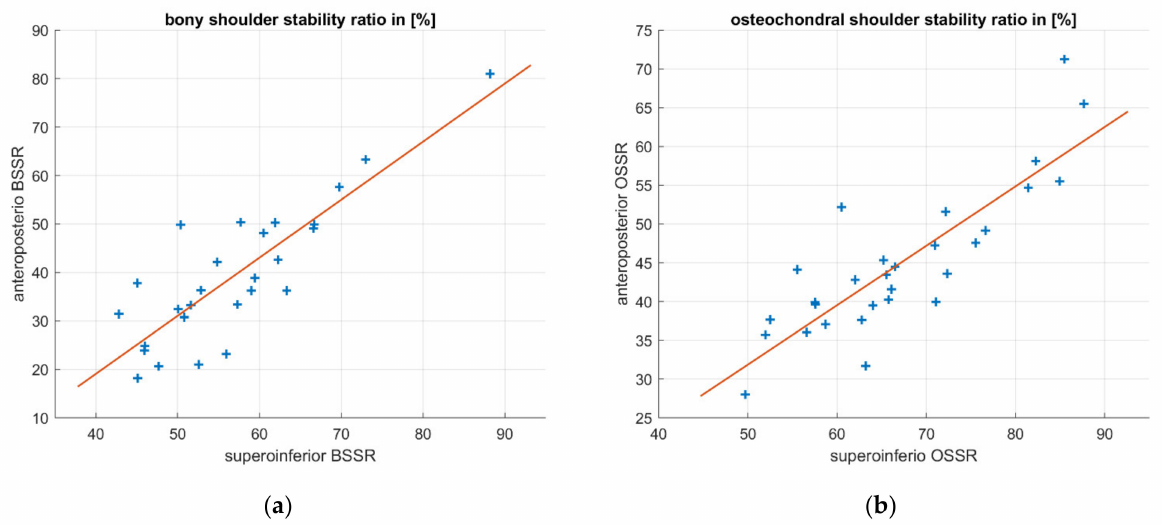
Figure 6. Linear regression of anteroposterior concavity as a function of superoinferior concavity for BSSR and OSSR separately. Both measurement methods reveal a high linear correlation that indicates predictability of anteroposterior concavity only by measuring superoinferior concavity: ( a ) BSSR; ( b )